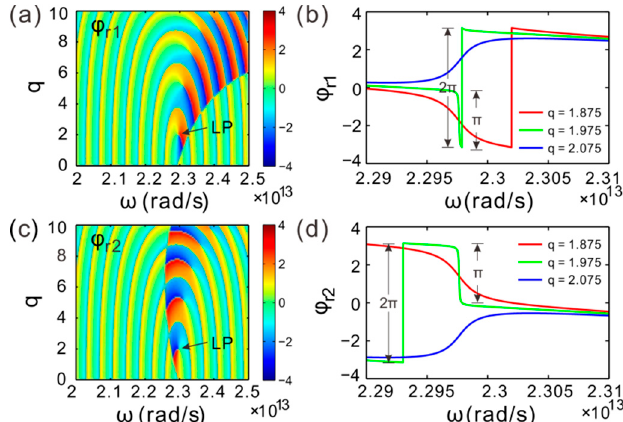
Figure 5. ( a , c ) The phase of reflection coefficient varying with the gain–loss factor and angular frequency for light incident from the left and right, respectively. ( b , d ) The phase curves versus the angular frequency for several specific refractive indices around the CPA-LP 1 for light incident from the left and right, respectively.